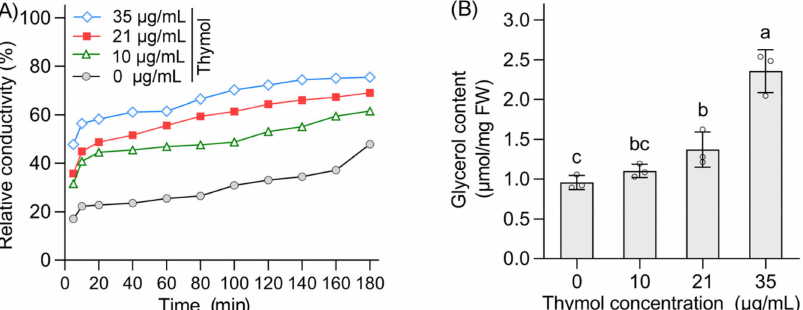
Figure 7. Thymol induced increase in relative conductivity and glycerol content in the mycelia of FON . ( A ) The relative conductivity of mycelia under thymol treatment (0, 10, 21, and 35 µ g/mL) was measured in a time-course process. ( B ) The mycelia were treated with thymol (0, 10, 21, and 35 µ g/mL) for 24 h, followed by the determination of glycerol content. Bars indicated SD of three replicates. Different lowercase letters in ( B ) indicated significant difference among different treatments (LSD, n = 3, p < 0.05).